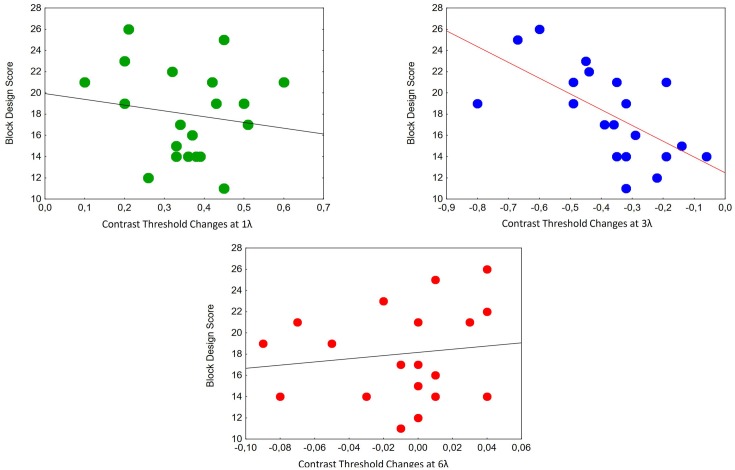
Correlations between contrast threshold changes and Block Design Scores at different target-mask distances in the perception task in individuals with ASC exhibiting a Block Design peak performance (n = 20). A significant relationship was found at 3λ (partial r = −0.65, p < 0.01).